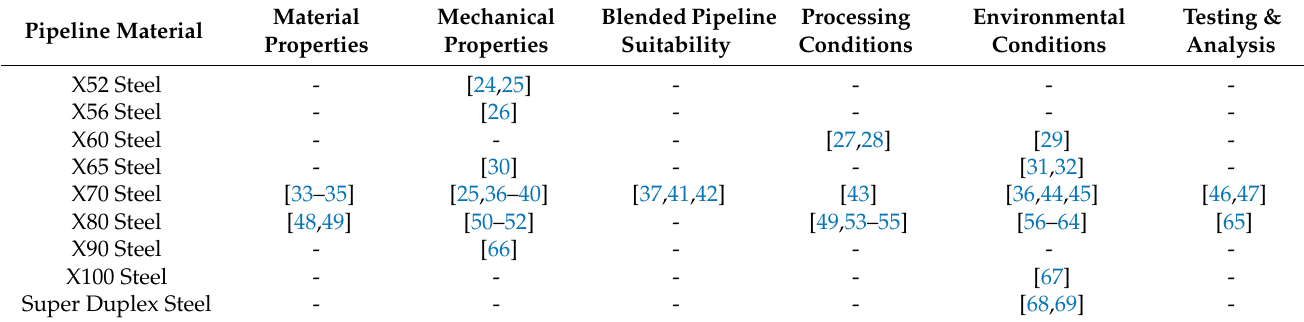
Table 4. An overview of findings in the existing literature about the properties of each pipeline steel